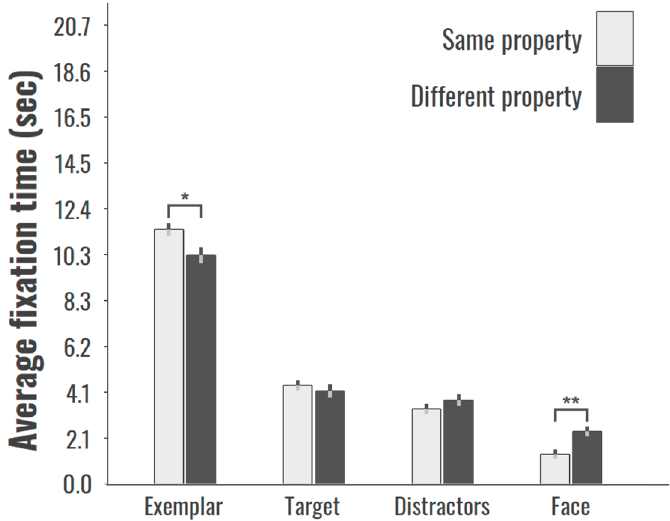
Figure 6. Mean duration of looking at the exemplar, the experimenter’s face, the target object, and the distractor test objects for the Same and Different conditions. Bootstrapped standard errors are shown as vertical lines.